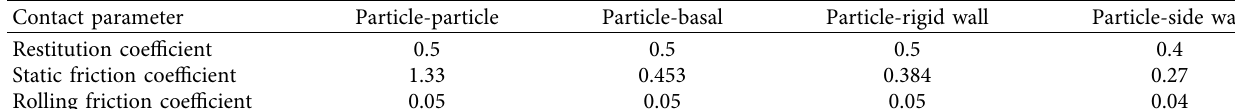
Table 2: Contact parameters of DEM model.